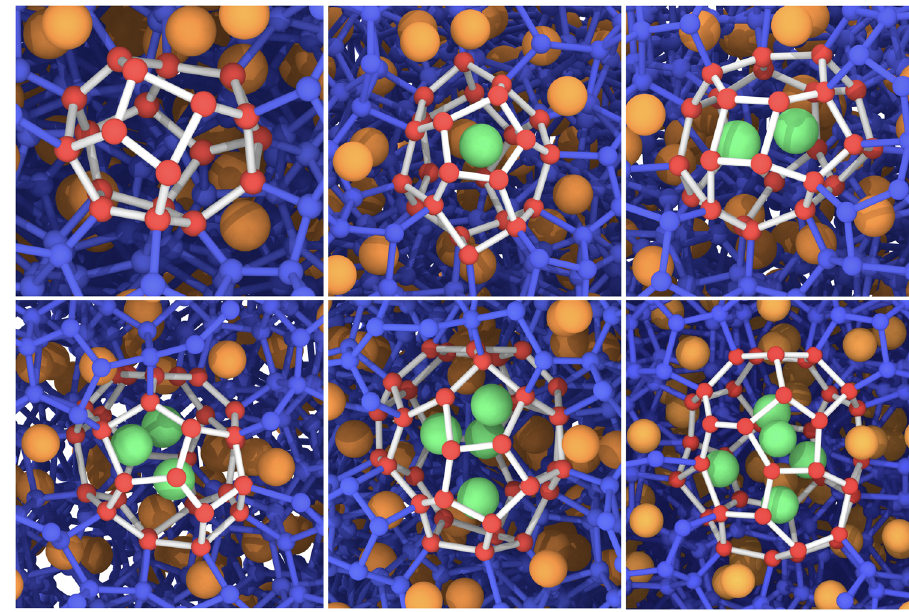
Figure 11: Snapshots from empty cages to quadruple - occupied cages in clathrate hydrate